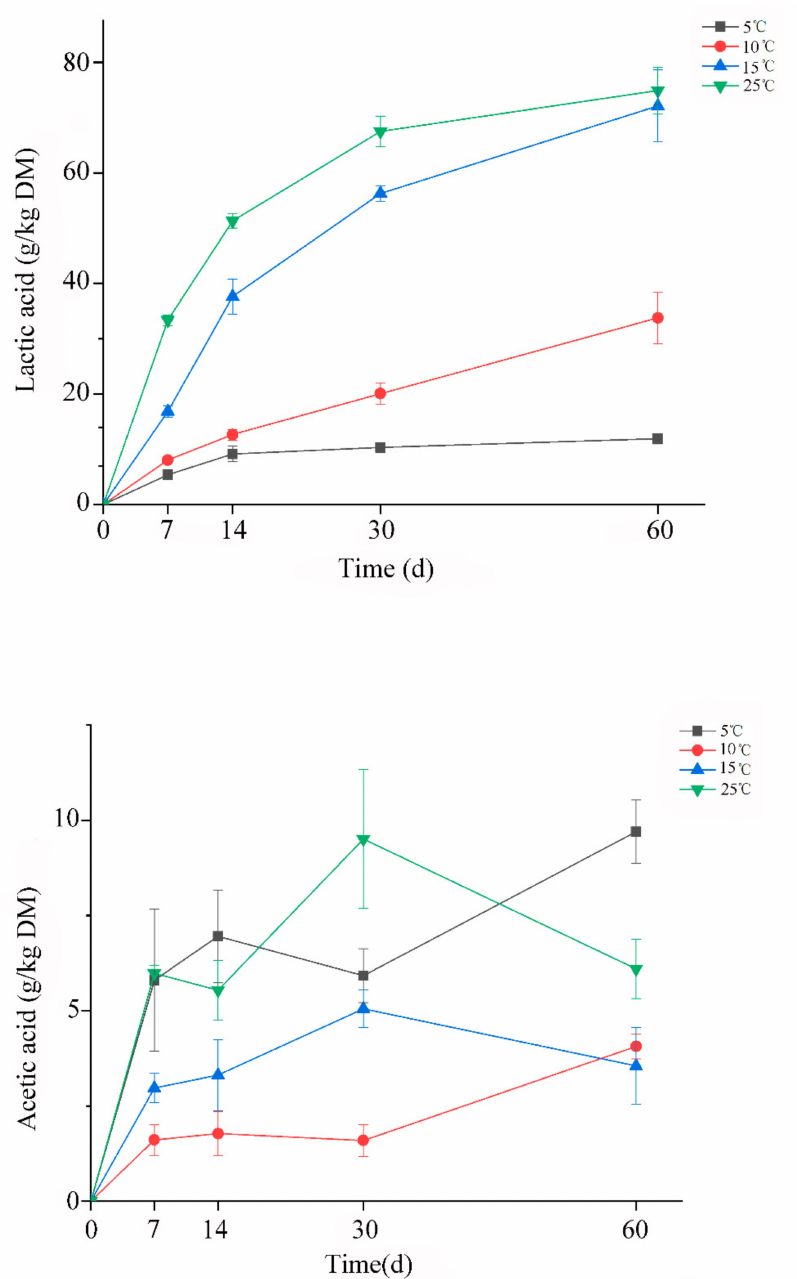
Figure 2. The change of organic acid for oat silages at different temperatures. Lactic acid and acetic acid were the dominant fermentation products in all silages, but propionic acid and butyric acid were not detected. Silages stored at higher temperatures (15 ◦ C and 25 ◦ C) produced higher lactic acid than at 5 ◦ C and 10 ◦ C. It was observed that a great difference of pH and lactic acid content appeared between 5–10 ◦ C and 15–25 ◦ C, indicating that the temperature ranging from 10 ◦ C to 15 ◦ C could be the boundary for oat silage fermentation. Unexpectedly, relatively high acetic acid content was found at 5 ◦ C, which was comparable to its lactic acid content. Lactic/acetic acid ratio close to 1:1 suggested hetero-fermentation, and this finding perhaps indicated that lower temperature leads to the fermentation pattern towards hetero-fermentation in oat silage. According to the bacterial community of oat silage (Figure 4), Levilactobacillus brevis was one of the bacterial indicators in 5 ◦ C silage, and its hetero-fermentative pattern could account for